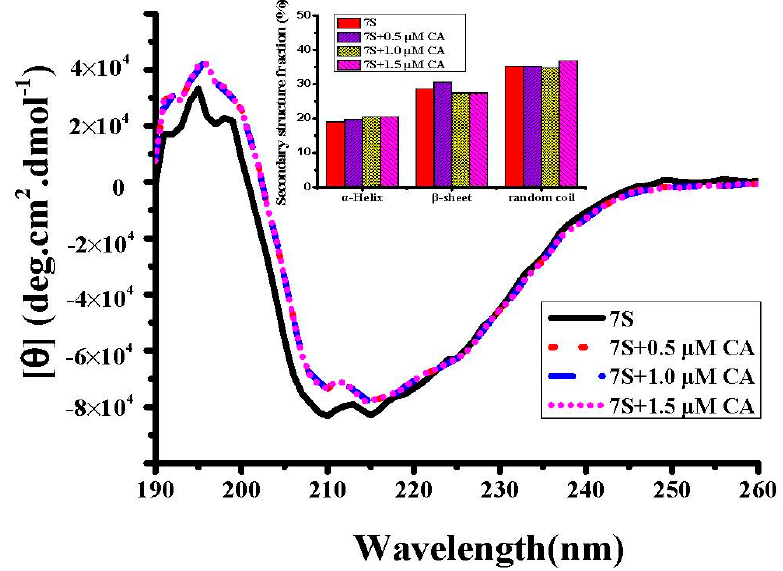
Figure 3. CD spectra of soy protein 7S in the presence and absence of CA. Inset: Estimated secondary structure fractions of soy protein 7S. Conditions: 0.5 μ M soy protein 7S in 100 mM MOPS (5 mM NaCl), pH 7.0, 25 °C.